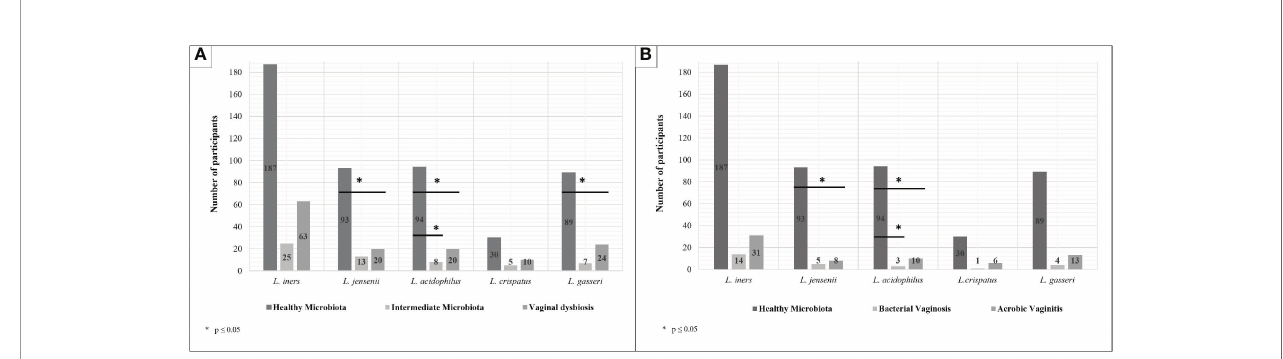
FIGURE 1 | Prevalence of each Lactobacillus species according to the type of vaginal microbiota. (A) Lactobacilli prevalence in healthy microbiota, intermediate microbiota, and vaginal dysbiosis. (B) Lactobacilli prevalence in healthy microbiota, bacterial vaginosis (BV), and aerobic vaginitis (AV). Chi-square tests were performed among the prevalence of each Lactobacillus species in the presence of healthy microbiota, intermediate microbiota, or vaginal dysbiosis (A) and then BV and aerobic vaginitis (AV) (B) . (A) The results show statistically signi fi cant differences between healthy and intermediate microbiota in Lactobacillus acidophilus ( p = 0.026) and Lactobacillus gasseri ( p = 0.020). Meanwhile, statistically signi fi cant differences between healthy microbiota and vaginal dysbiosis were shown in presence of Lactobacillus jensenii ( p = 0.017) and L. acidophilus ( p = 0.015). However, no statistically signi fi cant differences were established between intermediate microbiota and vaginal dysbiosis. (B) The results show statistically signi fi cant differences between healthy microbiota and AV in L. jensenii ( p = 0.012) and L. acidophilus ( p = 0.045). Meanwhile, only statistically signi fi cant differences between healthy microbiota and BV were shown in presence of L. acidophilus ( p = 0.041); no statistically signi fi cant differences were established between AV and